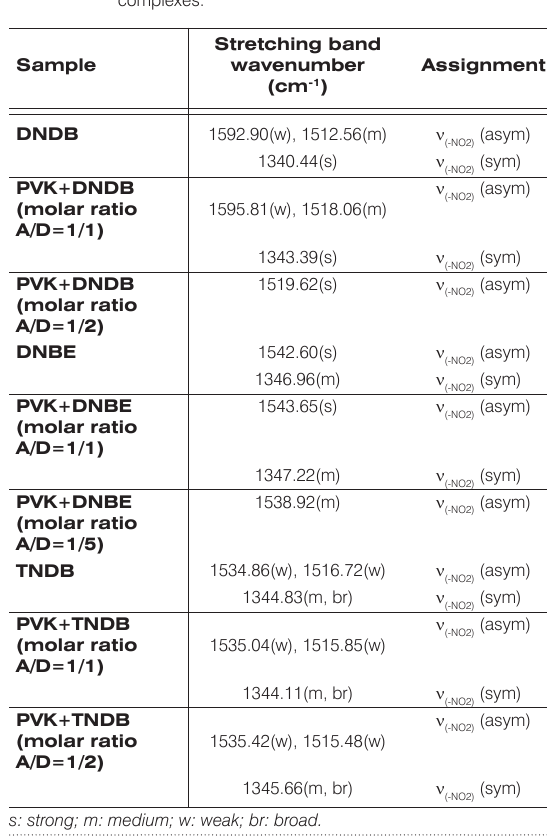
Table 3. Vibrational frequency assignments for acceptors and complexes.